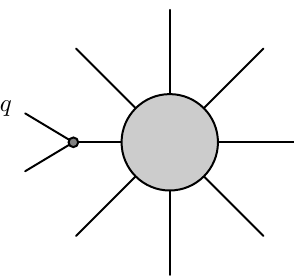
Figure 1. Emission of a soft particle with momentum q from a hard external